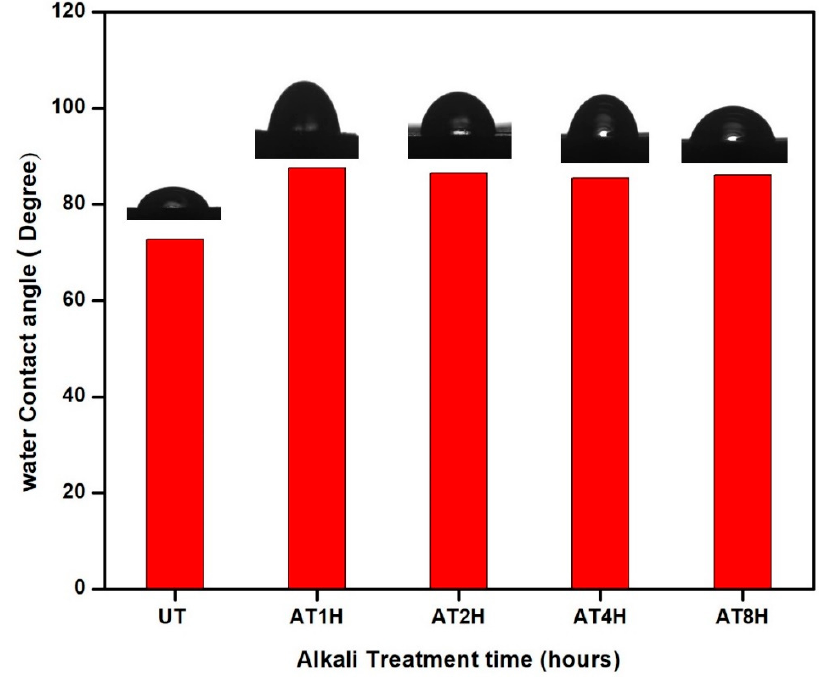
Figure 7. Contact angle of untreated and treated Typha fiber reinforced epoxy composite.